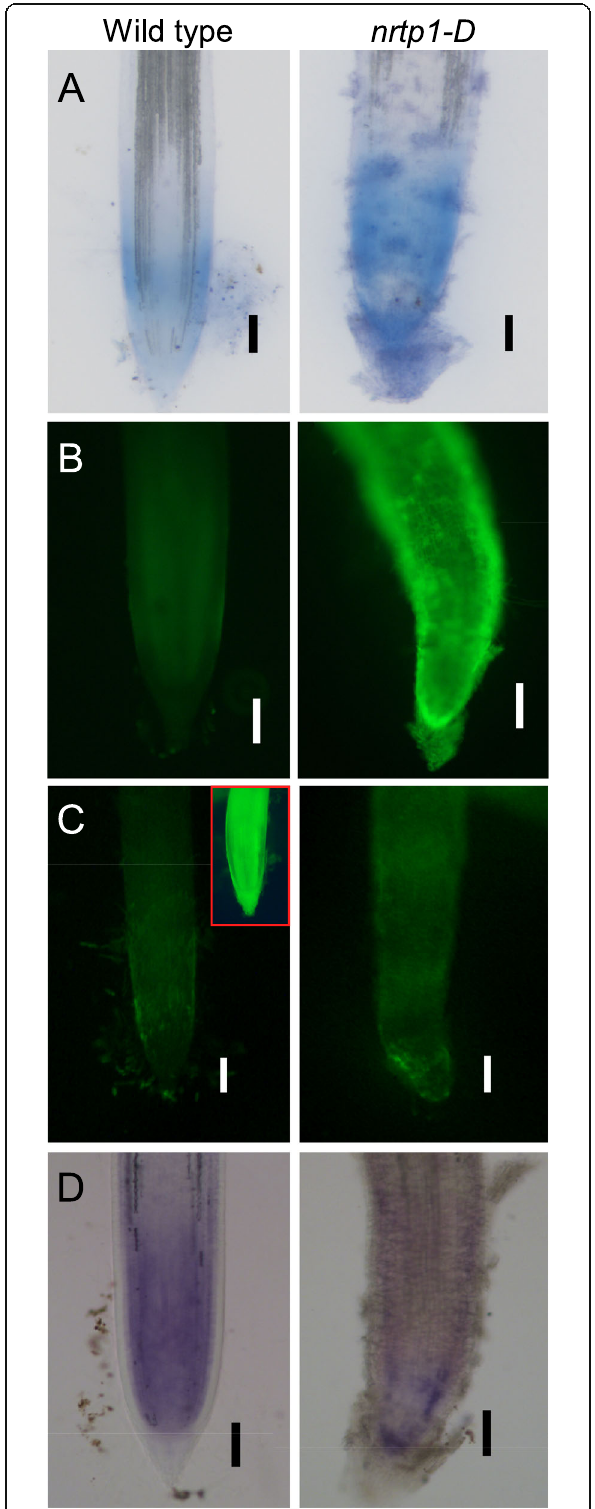
Fig. 6 Staining for dead cells, NO and ROS in nrtp1-D mutant roots. 7-d-old seedling root tips were stained by ( a ) Evans blue (to stain dead cells), ( b ) 4-amino-5-methylamino-2 ′ ,7 ′ -difluorofluorescein diacetate (to detect NO levels), ( c ) 3 ′ -( ρ -hydroxyphenyl) fluorescein (to detect ROS levels) and ( d ) Nitro blue tetrazolium (to detect H 2 O 2 and O 2.- levels), respectively. Insertion with red frame, positive control. Bars = 100 μ